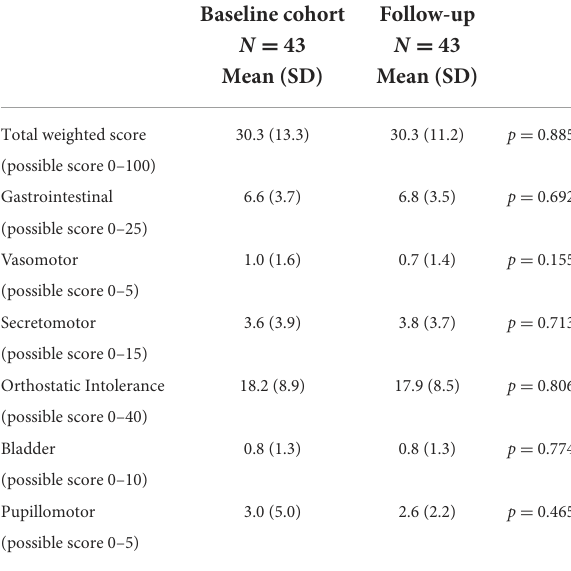
TABLE 2 COMPASS-31 autonomic symptom